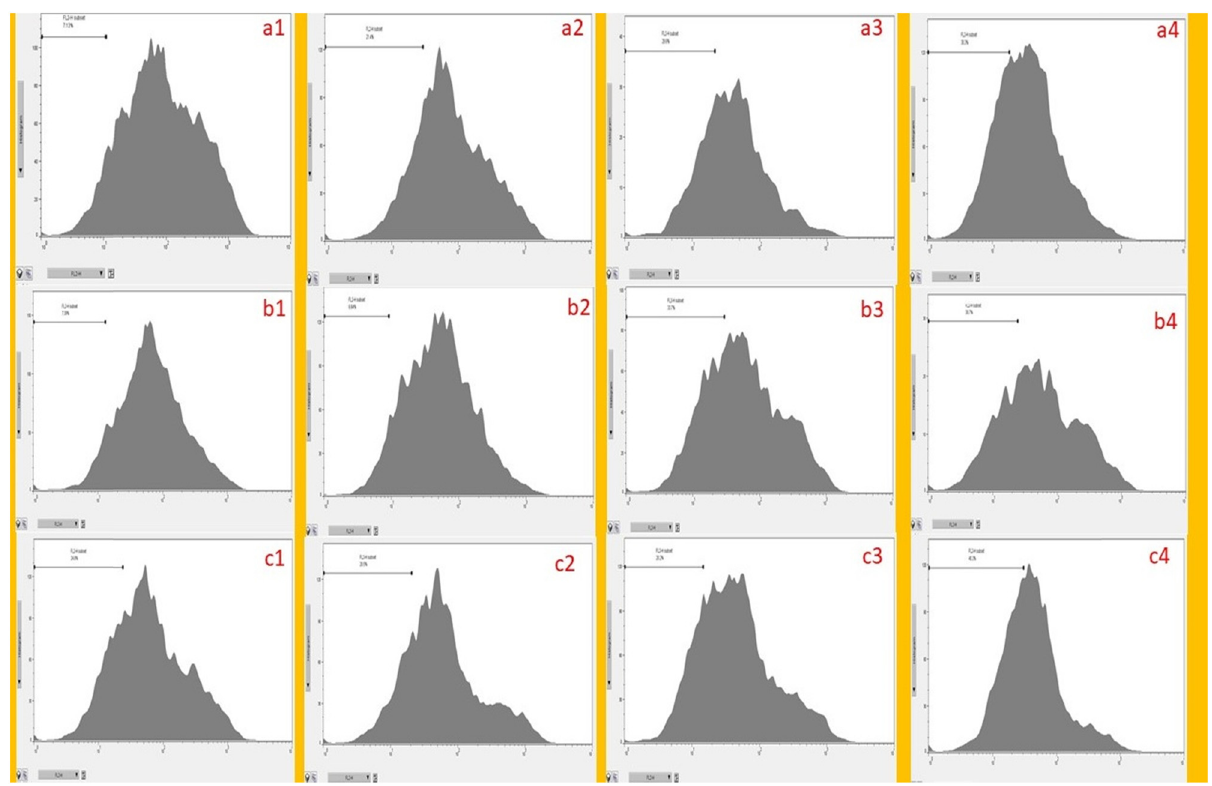
Figure 3: Flow cytometric evaluation of induced apoptosis using Propidium iodide staining by Equisetum arvense extract in LNCaP cells at di ff erent times and concentrations. a1 – 4 after 24 h; b1 – 4 after 48 h; and c1 – 4 after 72 h ( the vertical axial shows Histogram details, and the horizontal axial shows FL2 - H subset )